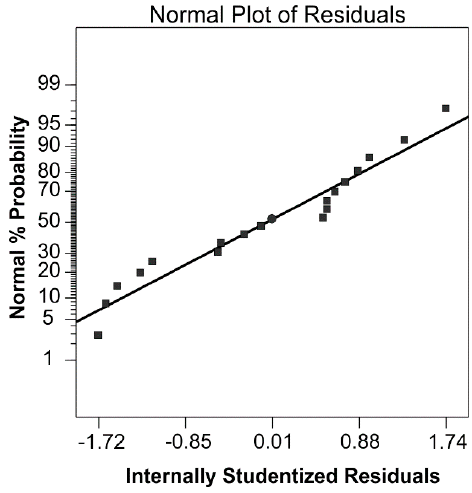
Figure 1. Normal probability plot of studentized residuals for the reduced polynomial model.